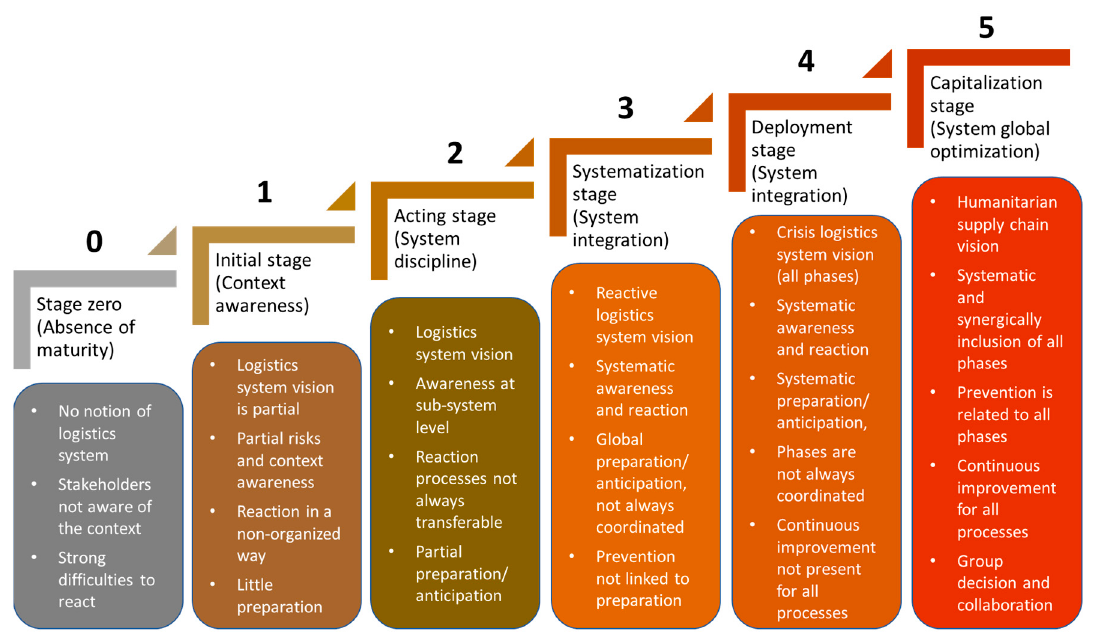
Figure 1. Proposal of a maturity model in the life cycle of recurrent crises.